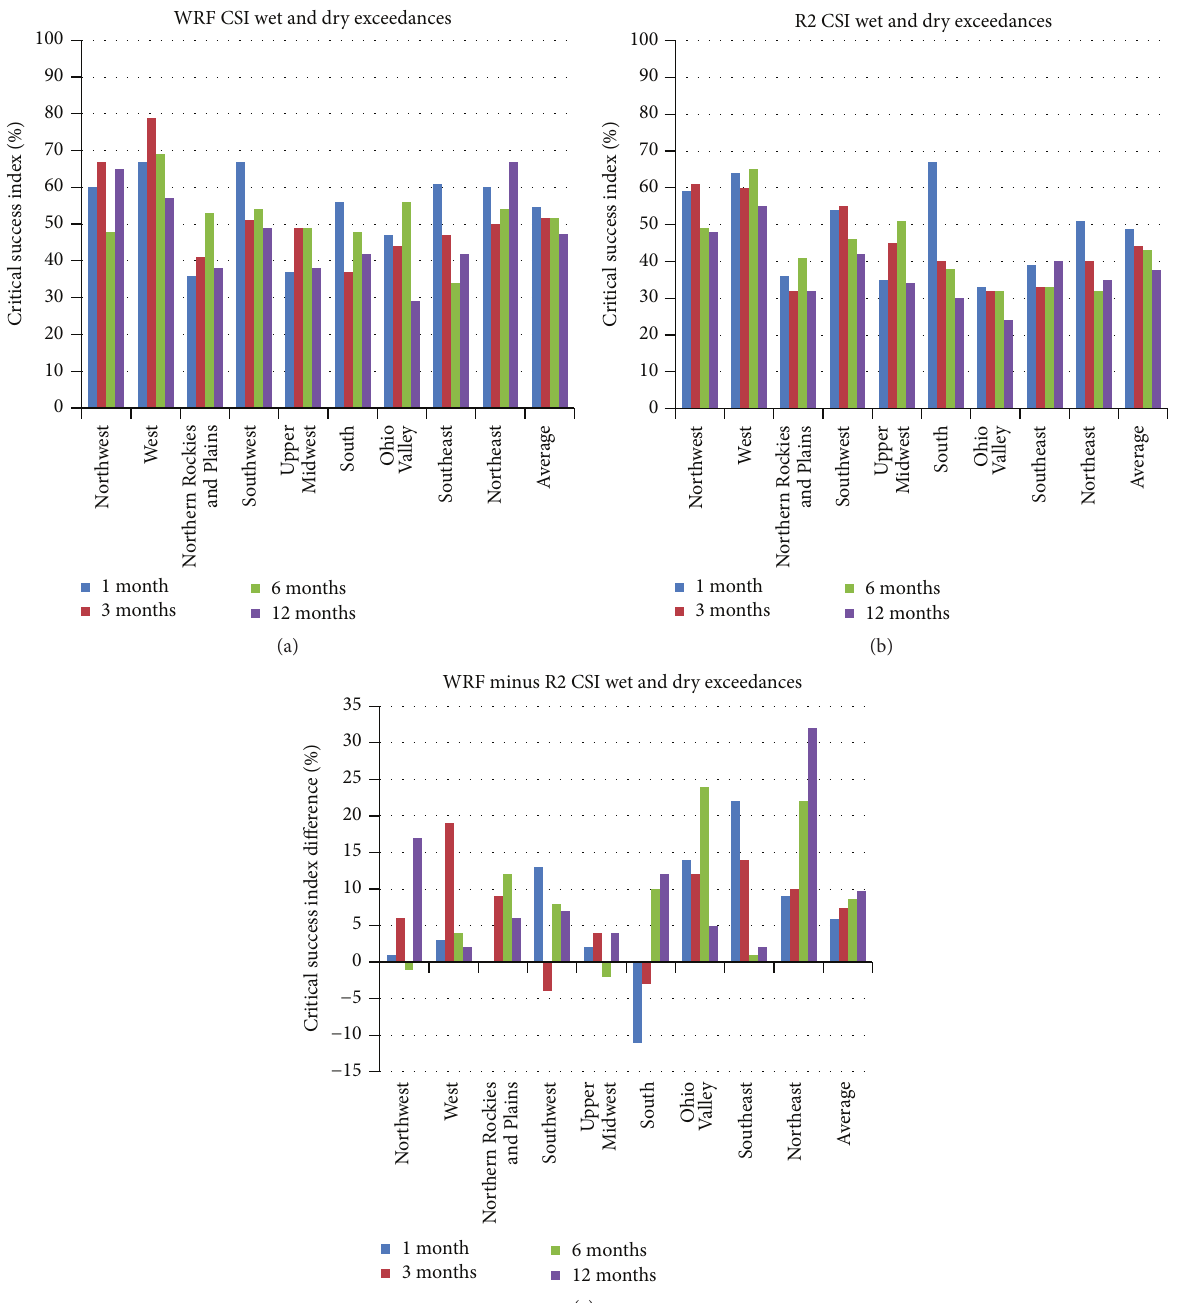
Figure 5: CSI for | SPI | > 1 between (a) WRF and PRISM and (b) R2 and PRISM for 1-, 3-, 6-, and 12-month accumulation periods averaged over each NCDC climate region. (c) Difference between WRF and R2 CSI (WRF minus R2) for the same periods and regions as in (a) and